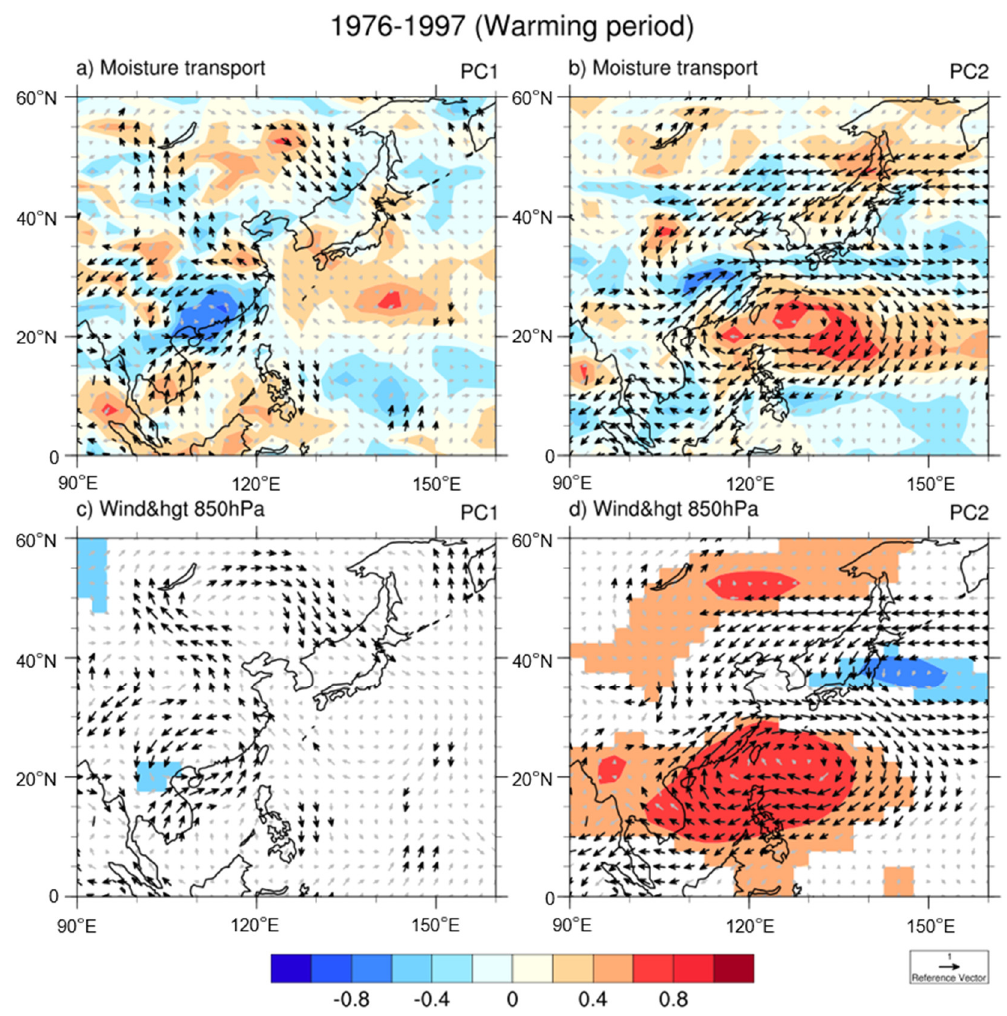
Figure 10. Same as Figure 8, but for the warming period (1976–1997).